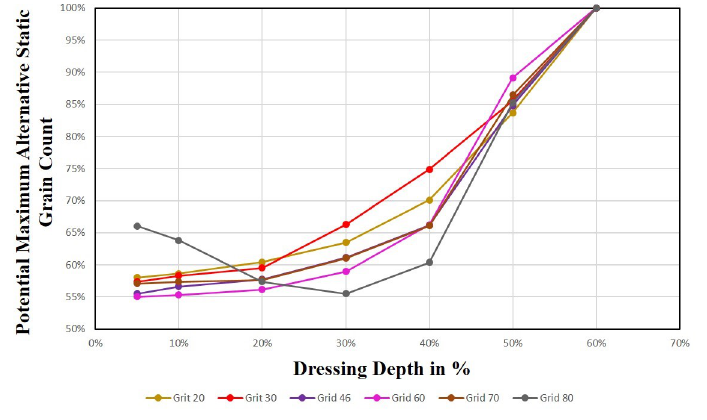
Figure 32. Potential maximum of alternative static grain count dependent on the percentual dressing depth.